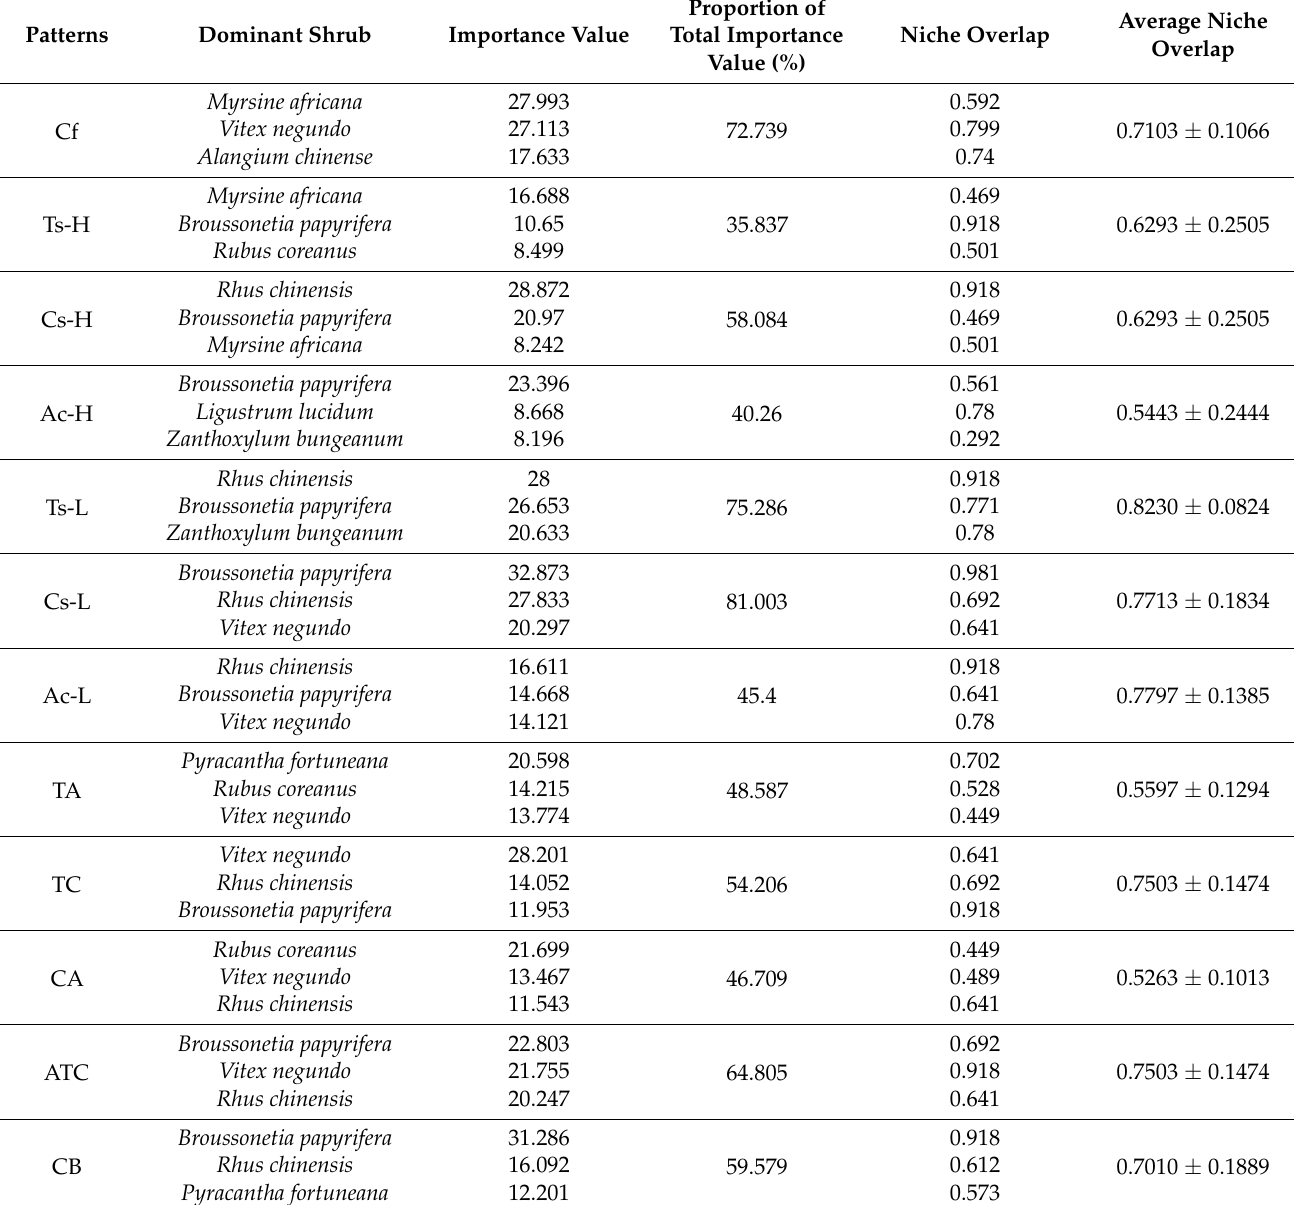
Table 4. The niche overlap of dominant shrubs in different reconstruction